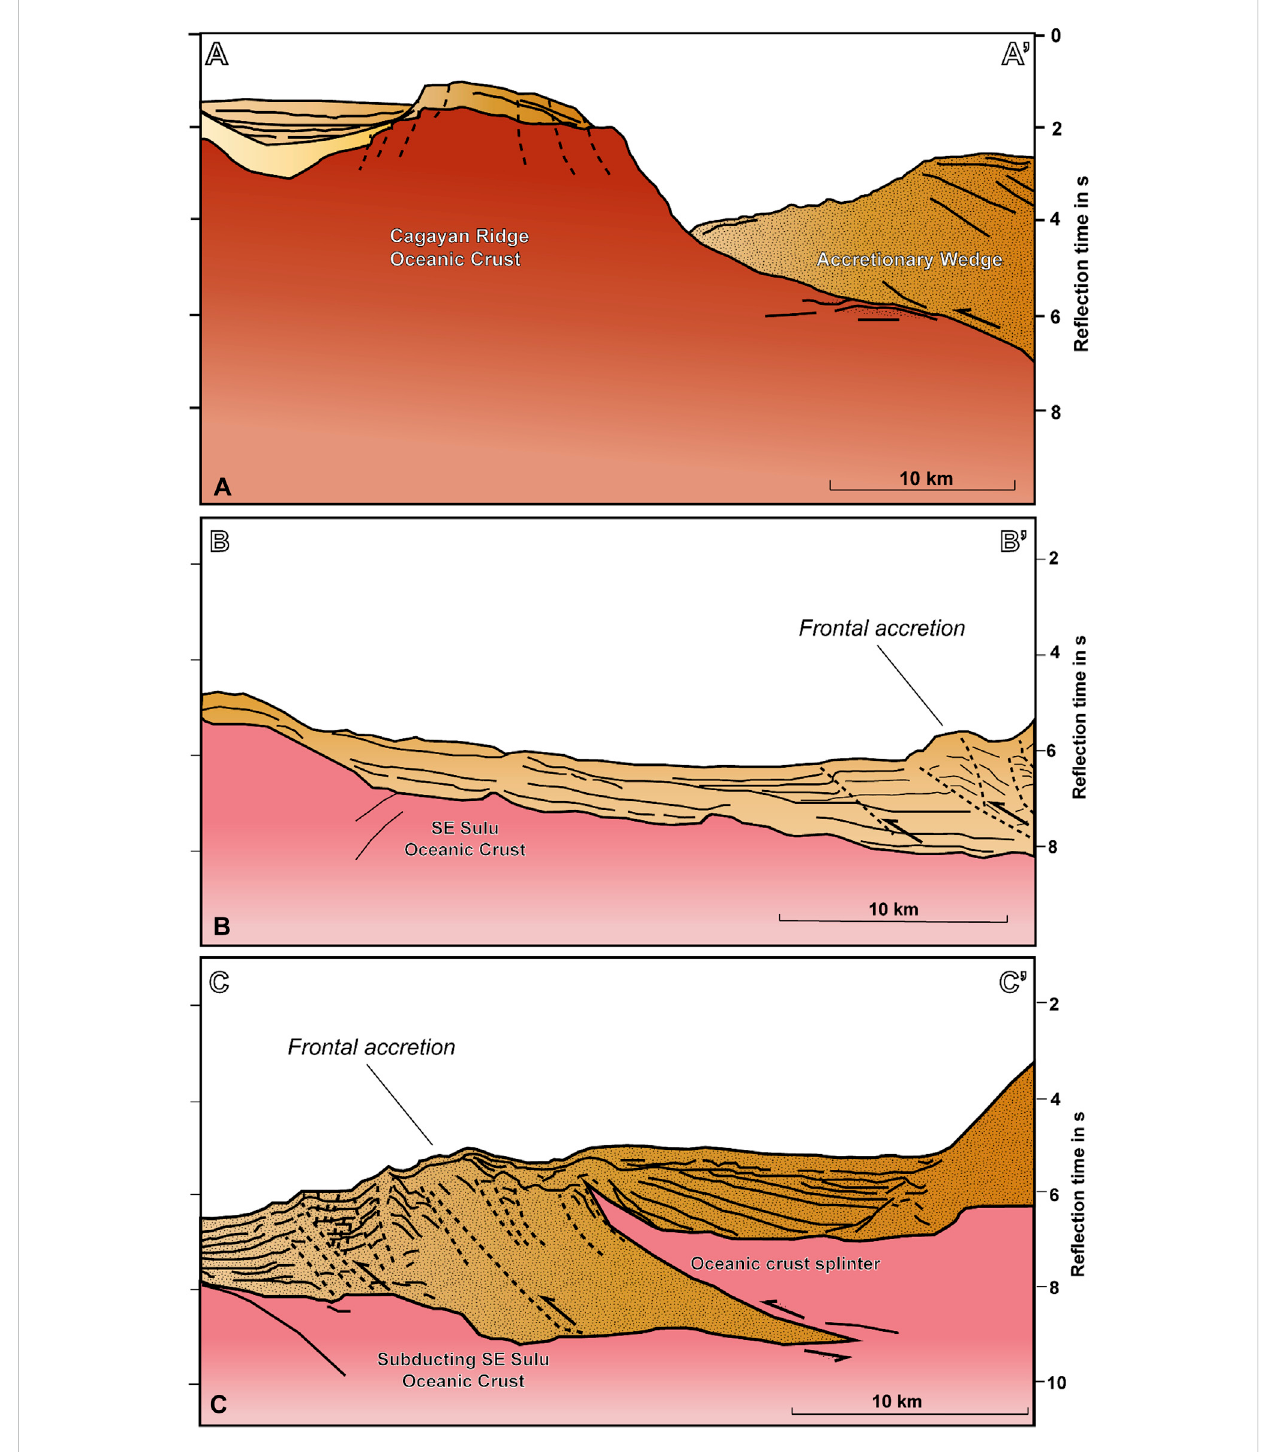
FIGURE 6 Interpreted seismic re fl ection pro fi les (as shown in Figure 4) perpendicular to the frontal wedge (adapted from Schlüter et al., 1996 with permission fromElsevier). (A) (LineSO49-16)CollisionandsubductionoftheCagayanRidgeseamountbeneaththenorthernaccretionaryprism. (B) (LineSO49-09) Reverse faults associated with the frontal accretion of sediments in the southern Negros Trench segment (NT2). (C) (Line SO 49-06) Dense high-angle reverse faults associated with frontal accretion in the northern Sulu Trench segment (ST1), manifested by dense lineaments and ridges as shown in Figure 5B. The identi fi ed oceanic splinter is linked to intense thrusting and folding along this